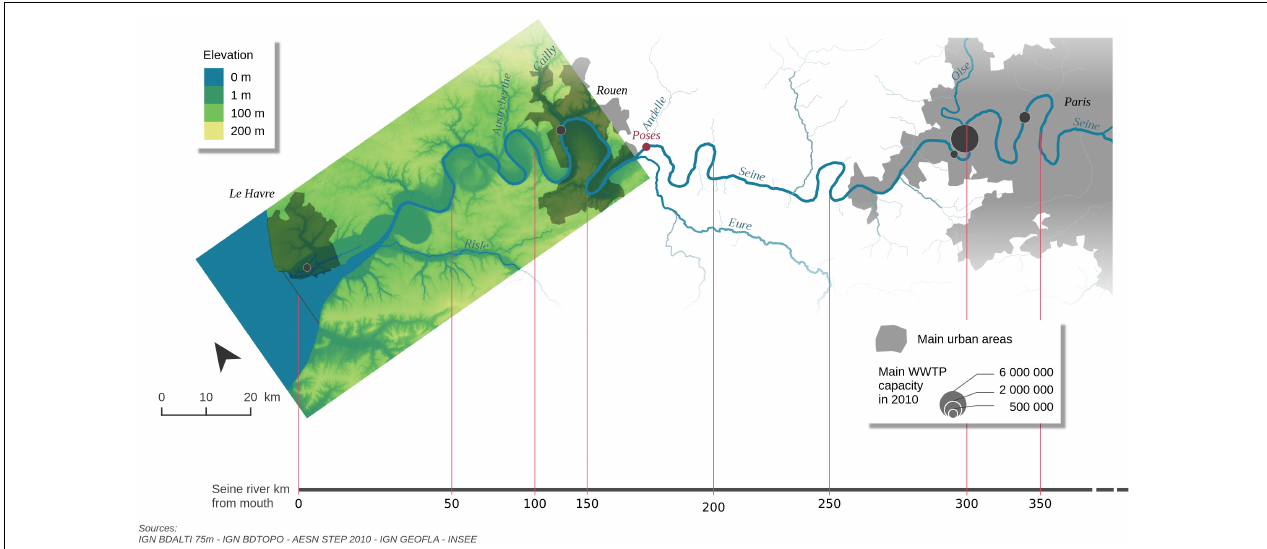
FIGURE 1 | Map of the Seine Estuary (colored sector) and upstream river network including its main tributaries. The model extends upstream of Paris to the confluence with the Marne